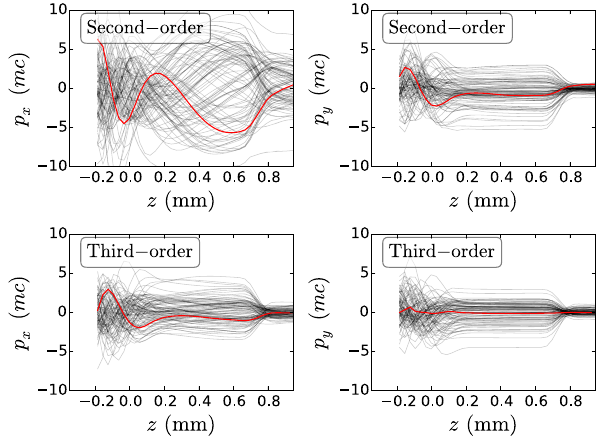
FIG. 9. Comparison of the simulation results with second-order accurate interpolation (top panels) and with third-order accurate interpolation (lower panels). The plots show the evolution of the transverse momenta p x (left panels) and p y (right panels) of the accelerated electrons throughout the